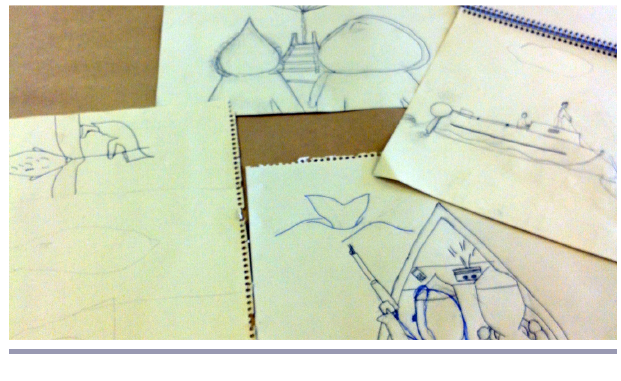
Fig. 2 . Photo of youth skteches created during the first workshop.